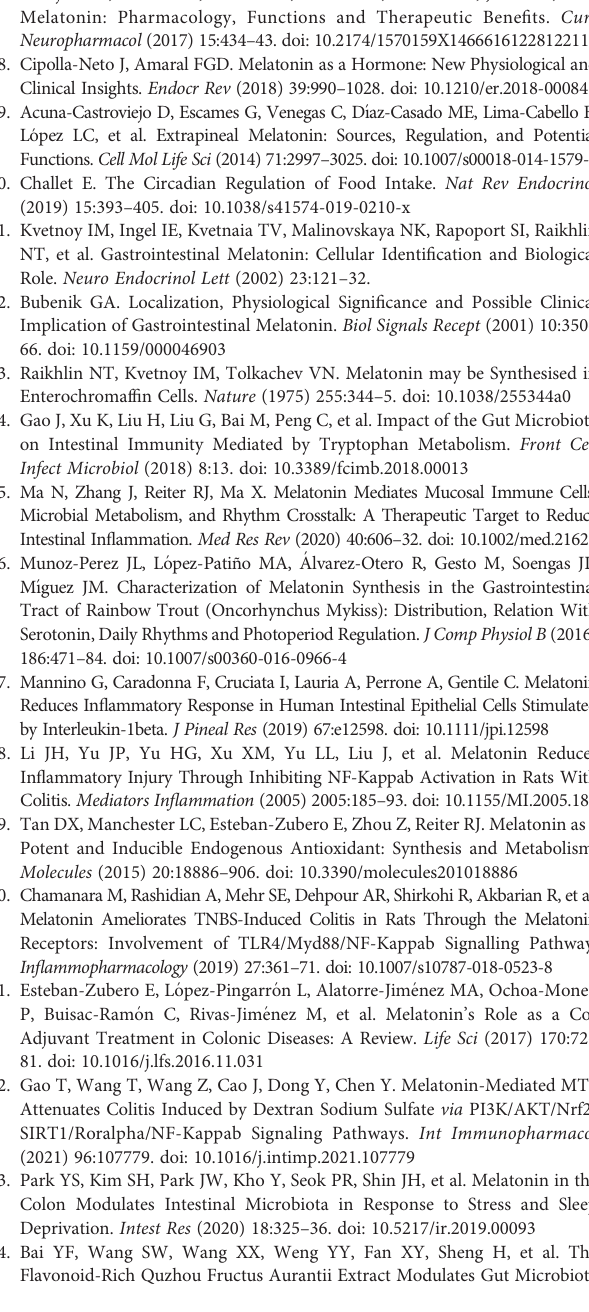
(G, H) Quanti fi cation of small and large intestinal CD45 + Lin — ROR g t + ILC3s function treated by melatonin for 16 hours in LPLs in vitro . Data are representative of at least two independent experiments. Data are shown as mean ± SD. * p < 0.05; ** p < 0.01; *** p < 0.001. Supplementary Figure 3 | (Related to Figure 5 ) Melatonin alters microbiota composition. (A) Community bar plot analysis of fecal microbiota from separated and co-housed mice for 7-day-melatonin-treatment on Phylum levels. (B) Heatmap of different genus between separated and co-housed mice for 7-day-melatonin- treatment. (C) Contribution offecal microbiota from separated and co-housed mice for 7-day-melatonin-treatment on genus levels in Circos